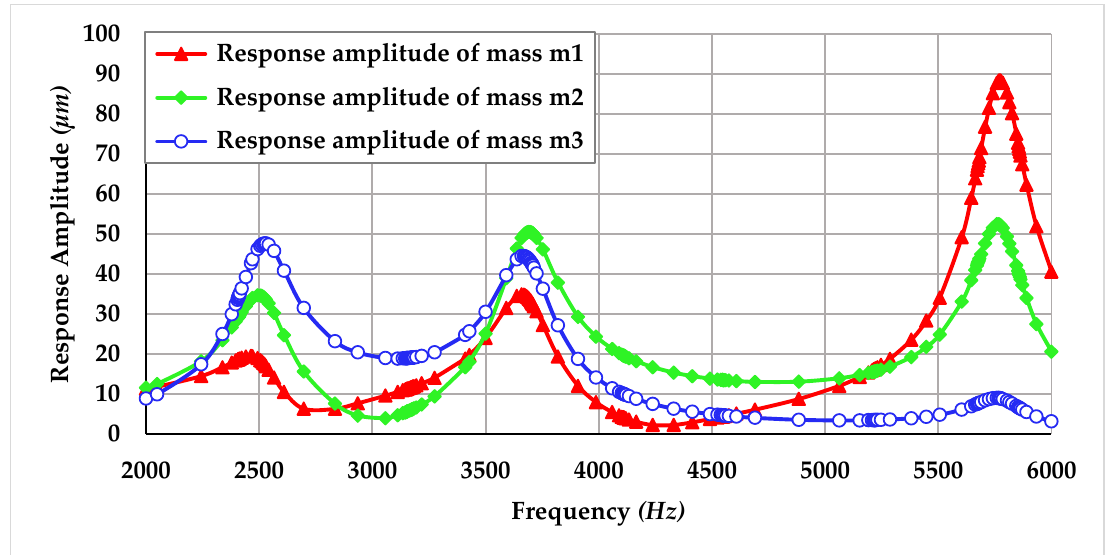
Figure 19. Frequency response of the proposed MEMS gyroscope in the drive mode.